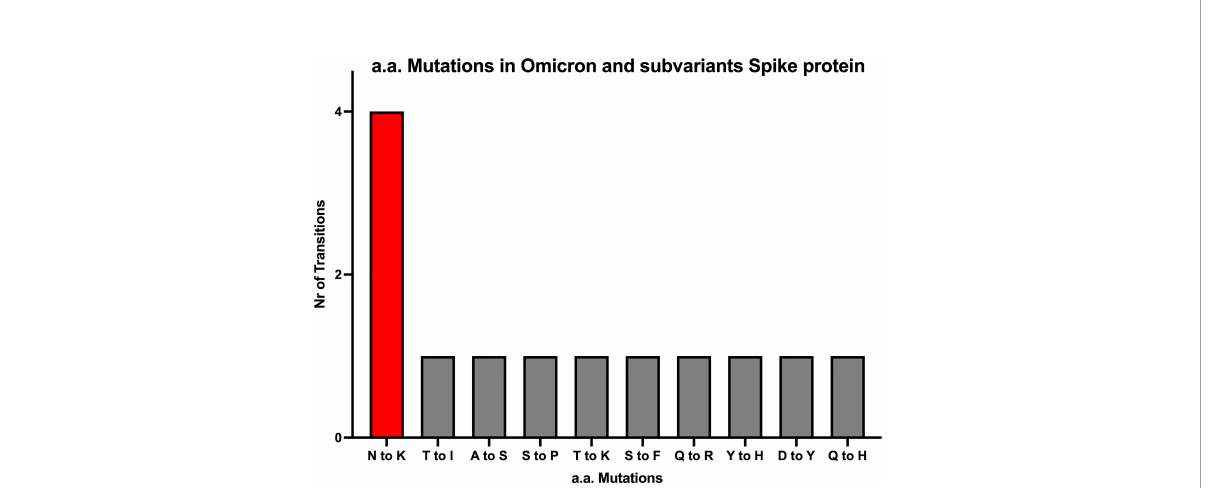
FIGURE 2 All amino acid mutations in Omicron Spike protein. The numbers of N to K mutations are about 4-fold higher compared to 9 other mutations occurring in the SARS-CoV-2 Spike region of Omicron and it ’ s